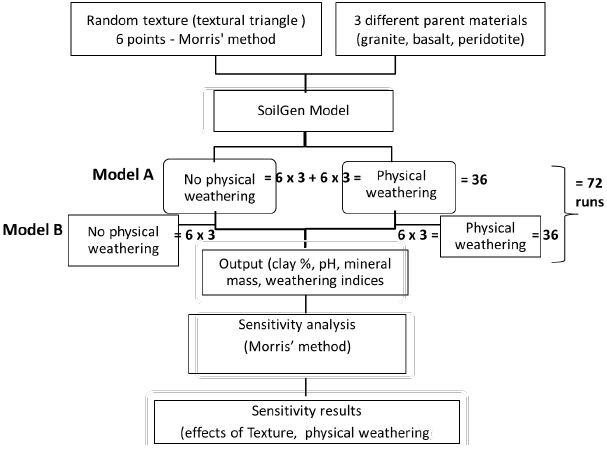
Figure 1. Research set